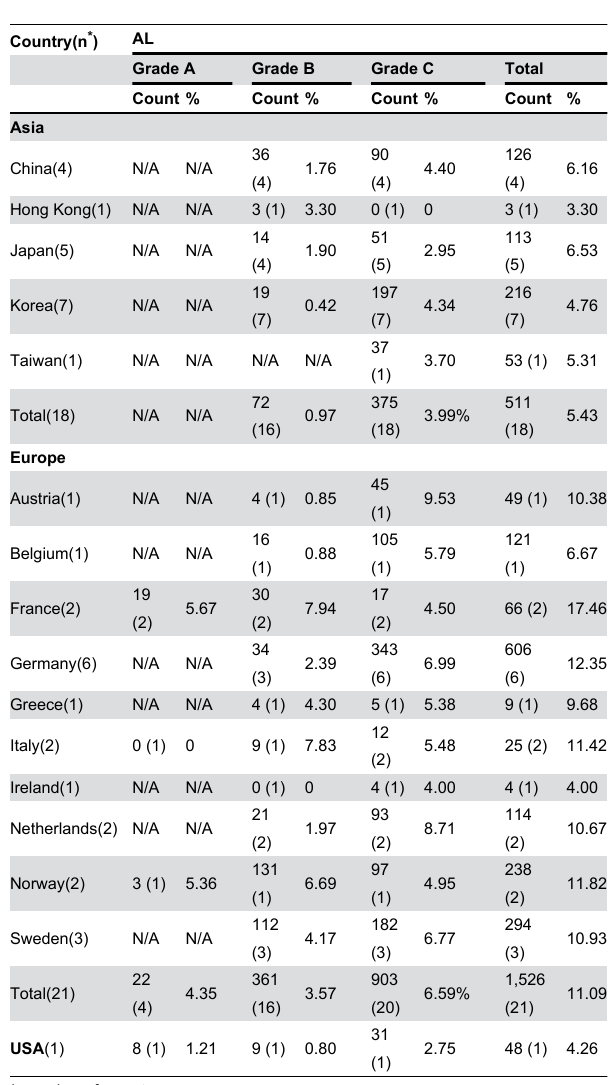
Table 1. Pooled rate of AL for each grade after AR in different